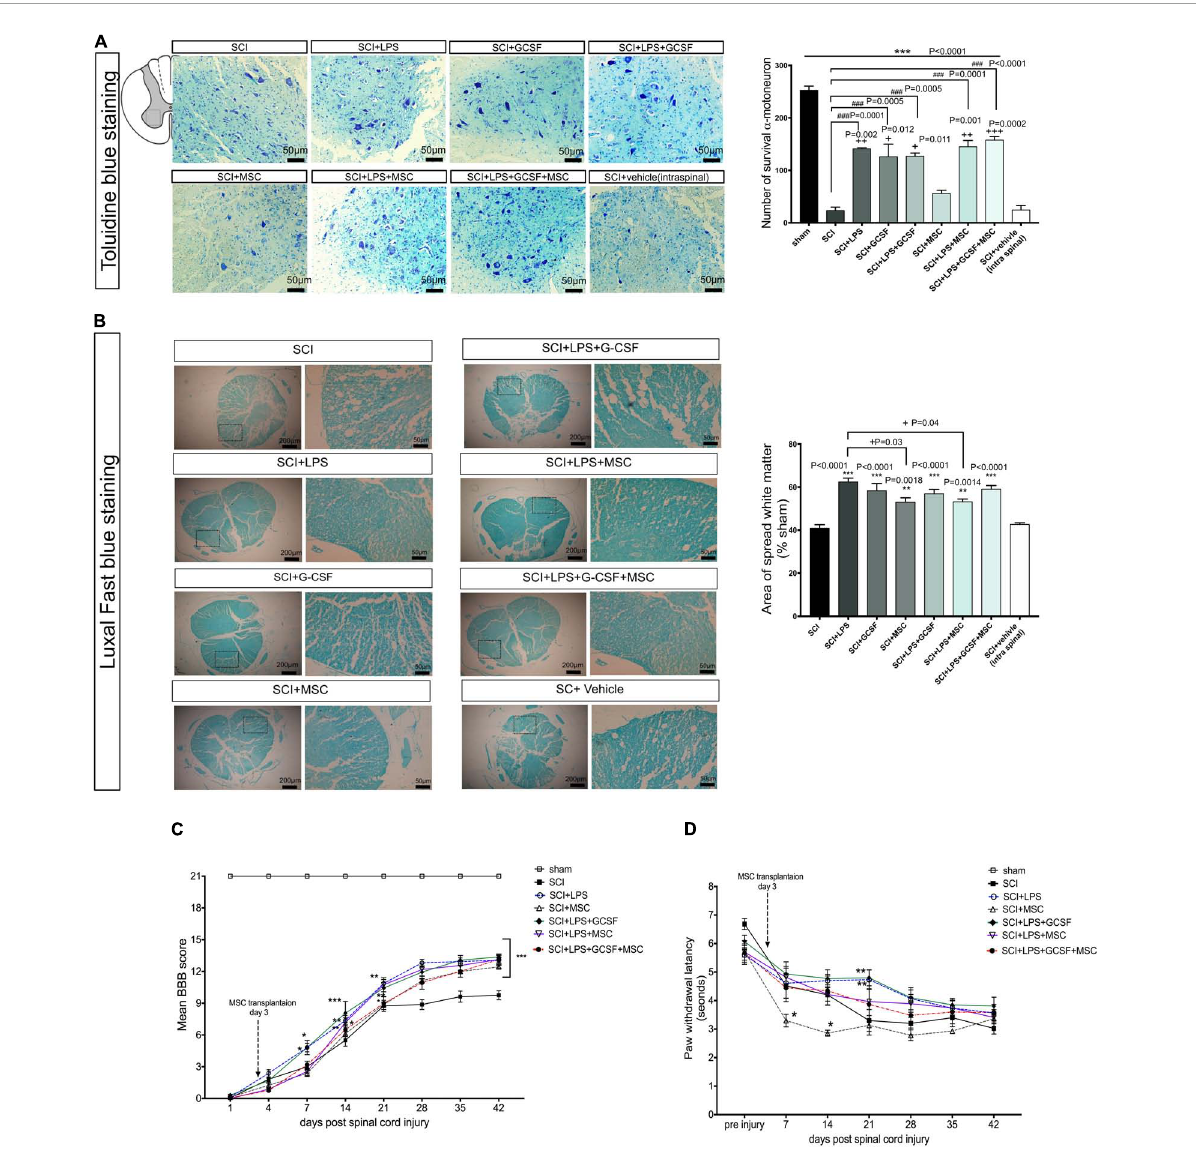
FIGURE9 Combination therapy alleviated histophathological change and functional impairment after SCI. (A) Toluidine blue staining of the lesion center results in the ventral horn of the spinal cord in the different groups at 7 days after SCI. Drug therapy or combined with MSC transplantation reduces motor neuron loss after SCI. (B) Luxol fast blue staining at the injured area. Bar graph showing the percentage of white matter sparing (WMS) compared to sham animals WMS represents the spared WMA at the injured site divided by the WMA of control sections of sham animals. There is no significant difference between treatment groups. (C) Motor function was assessed using the Basso, Beattie, Bresnahan (BBB) locomotor rating scale. A gradual recovery of hind-limb locomotion was observed in all rats over the following 42 weeks. Repeated measures two-way ANOVA, Tukey’s post-hoc test. (D) Thermal hyperalgesia in the hot plate test was observed during 42 weeks. * P < 0.05, ** P < 0.01, and *** P < 0.001 versus SCI. Data represent mean values ± SEM, * P < 0.05, ** P < 0.01, *** P < 0.001 versus the SCI group, and + P < 0.05, ++ P < 0.01, +++ P < 0.001 versus the MSC group, n = 3 per group. ### P < 0.001 versus